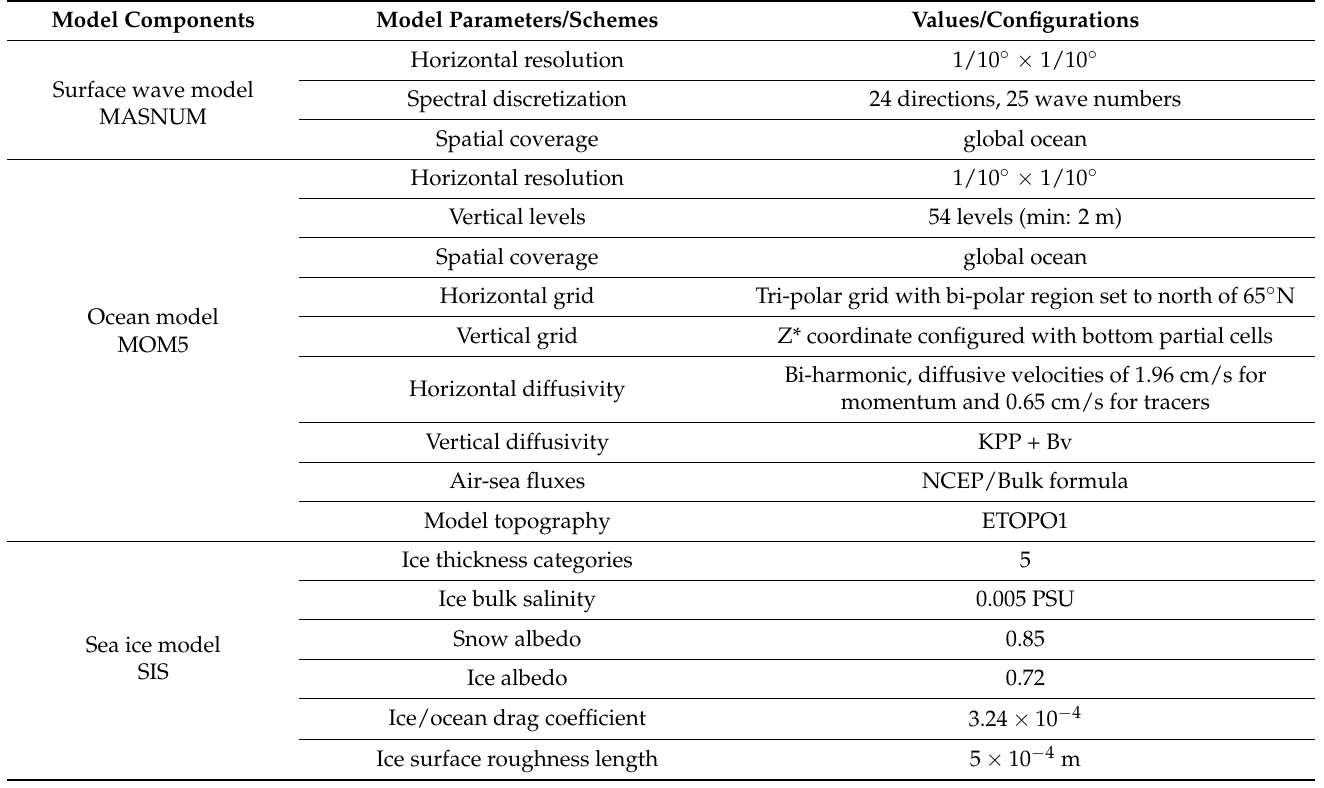
Table 1. Model configurations of